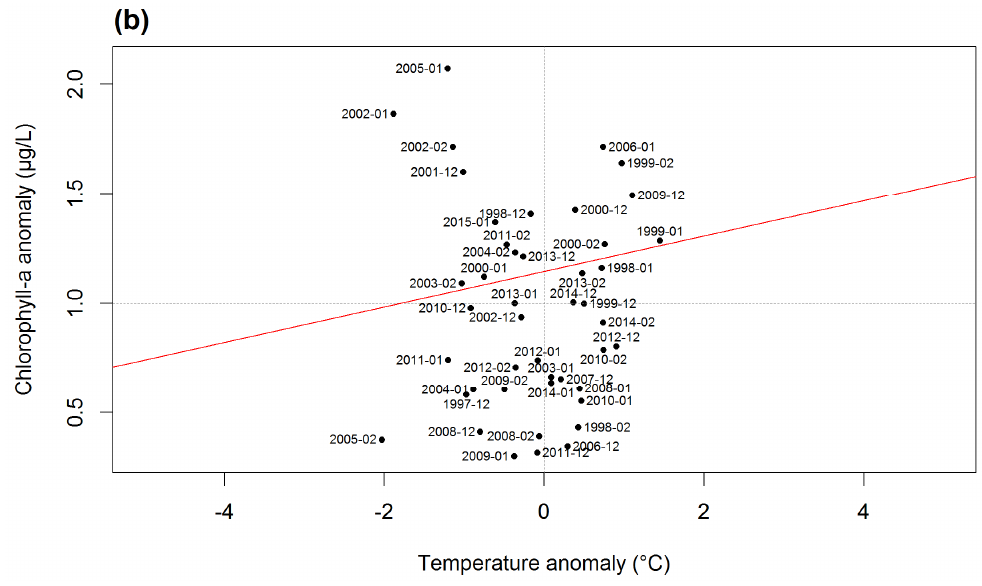
Figure 3. Comparison of ( a ) model derived climate sensitivity to ( b ) empirical reservoir climate sensitivity of chlorophyll- a to temperature in summer (December, January, February). In panel ( b ) each point represents the unity normalized anomaly from the monthly median value calculated over the period 1998–2013 and is labeled as